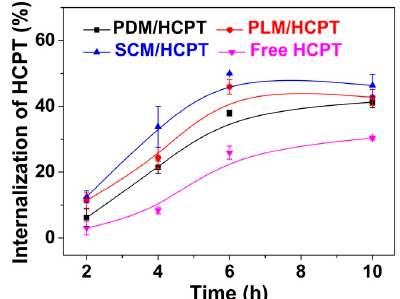
Figure 7. Cellular uptake of HCPT toward MCF-7 cells after incubation with PDM/HCPT, PLM/HCPT, SCM/HCPT, or free HCPT for various durations. Data are shown as mean ± SD ( n = 4).